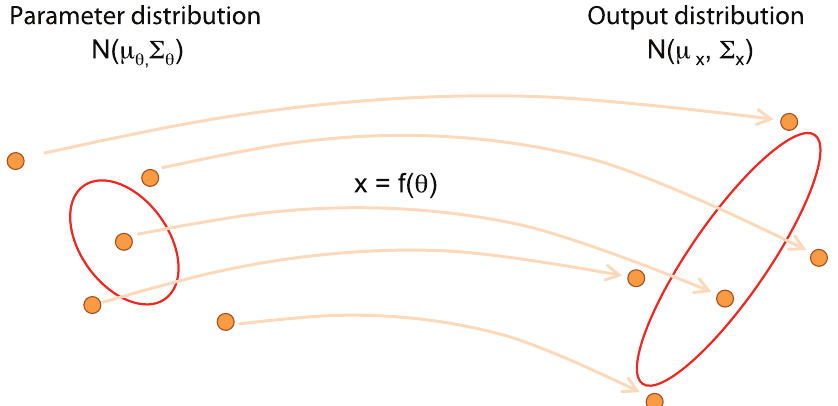
Figure 13. Schematic representation of the unscented transform. Adapted from ref. [36]. The UT provides a mechanism for approximating the output distribution N ( m x , S x ) obtained by propagating the input parameter distribution N ( m h , S h ) through the function x s ~ f ( h s ) . It does this by deterministically choosing a minimal set of sample points (called sigma points; filled circles to left) from the parameter distribution, h s * N ( m h , S h ) . Sigma points are then propagated through function f , x s ~ f ( h s ) (filled circles to right), and re-assembled into a Gaussian distribution on the output, N ( m x , S x ) , which approximates the output distribution by the first two moments (ellipse to right).